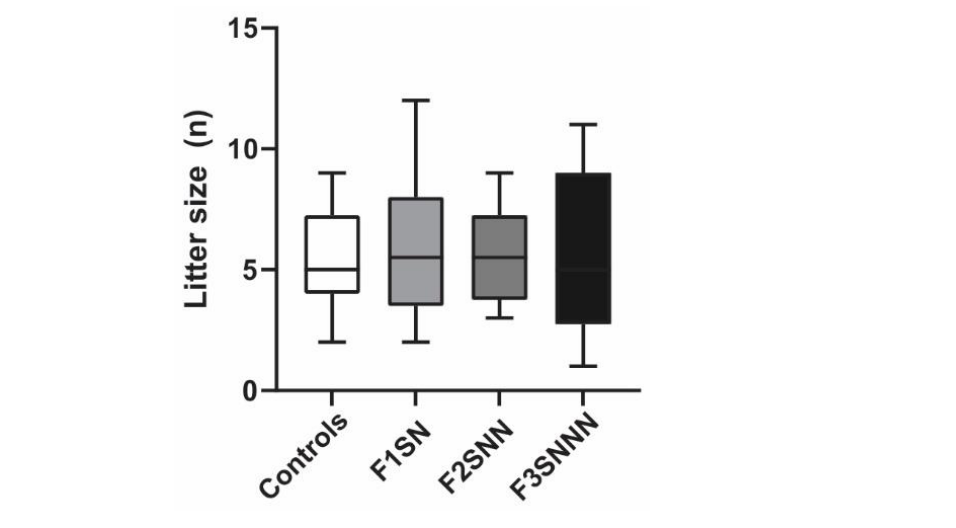
Figure 4. Litter sizes were unchanged between treatments. Data are compared to F1NN and were analyzed using the Kruskal-Wallis test. Box plot mid-lines indicate medians, whiskers indicate min-max values, and boxes indicate interquartile ranges. N = 14–22 per group. F = filial generation; S = stressed; N = nonstressed.